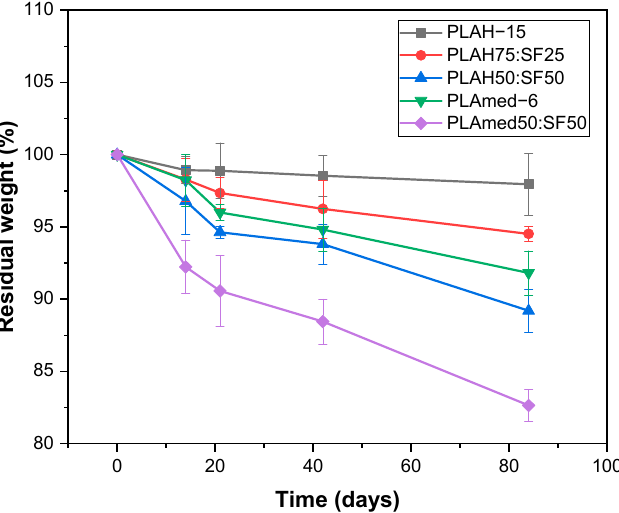
Figure 8. Residual weight (%) of electrospun scaffolds after degradation in phosphate buffered saline (PBS, pH = 7.4) as a function of time.